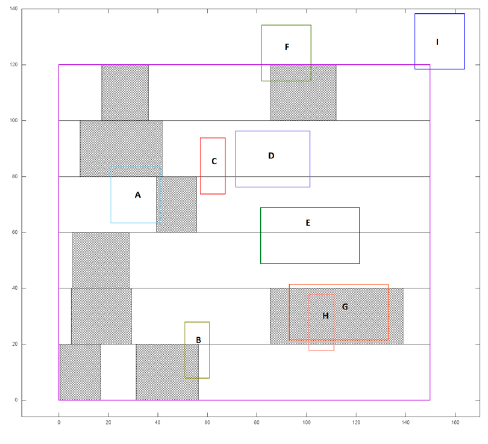
Figure 1. Example global placement